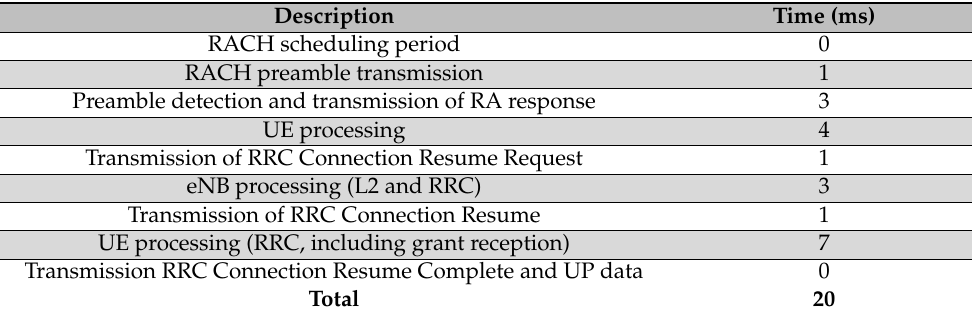
Table 8. Control plane delay for the INACTIVE-CONNECTED state with the LTE Radio Access Network (RAN) and 5G Core [28]. Description Time (ms) RACH scheduling period 0 RACH preamble transmission